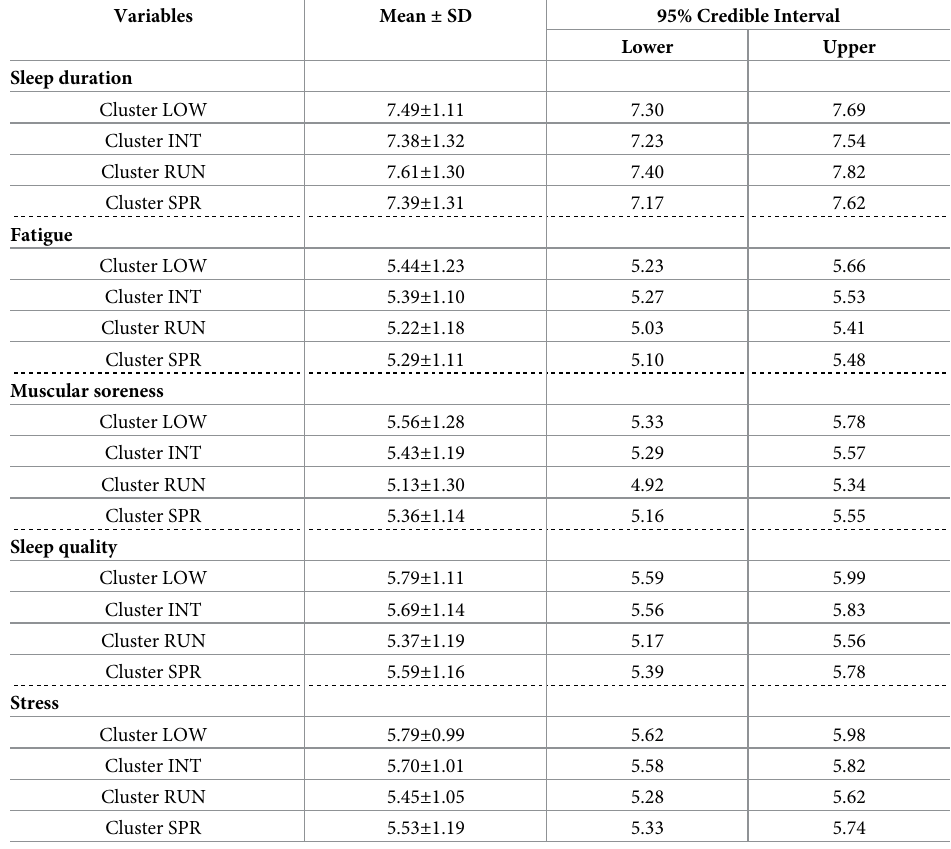
Table 3. Descriptive analysis of the model averaged posterior